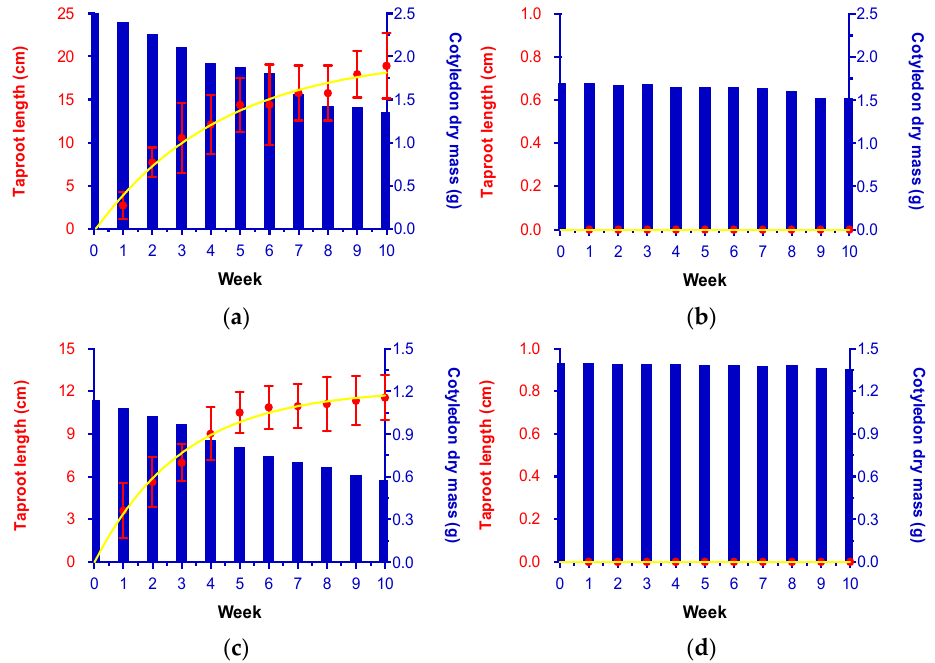
Figure 1. Exploitation of cotyledons and taproot elongation of Q. variabilis ( a ), Q. accutissima ( b ), Q. serrata ( c ), and C. glauca ( d ) along with exploitation of acorns.